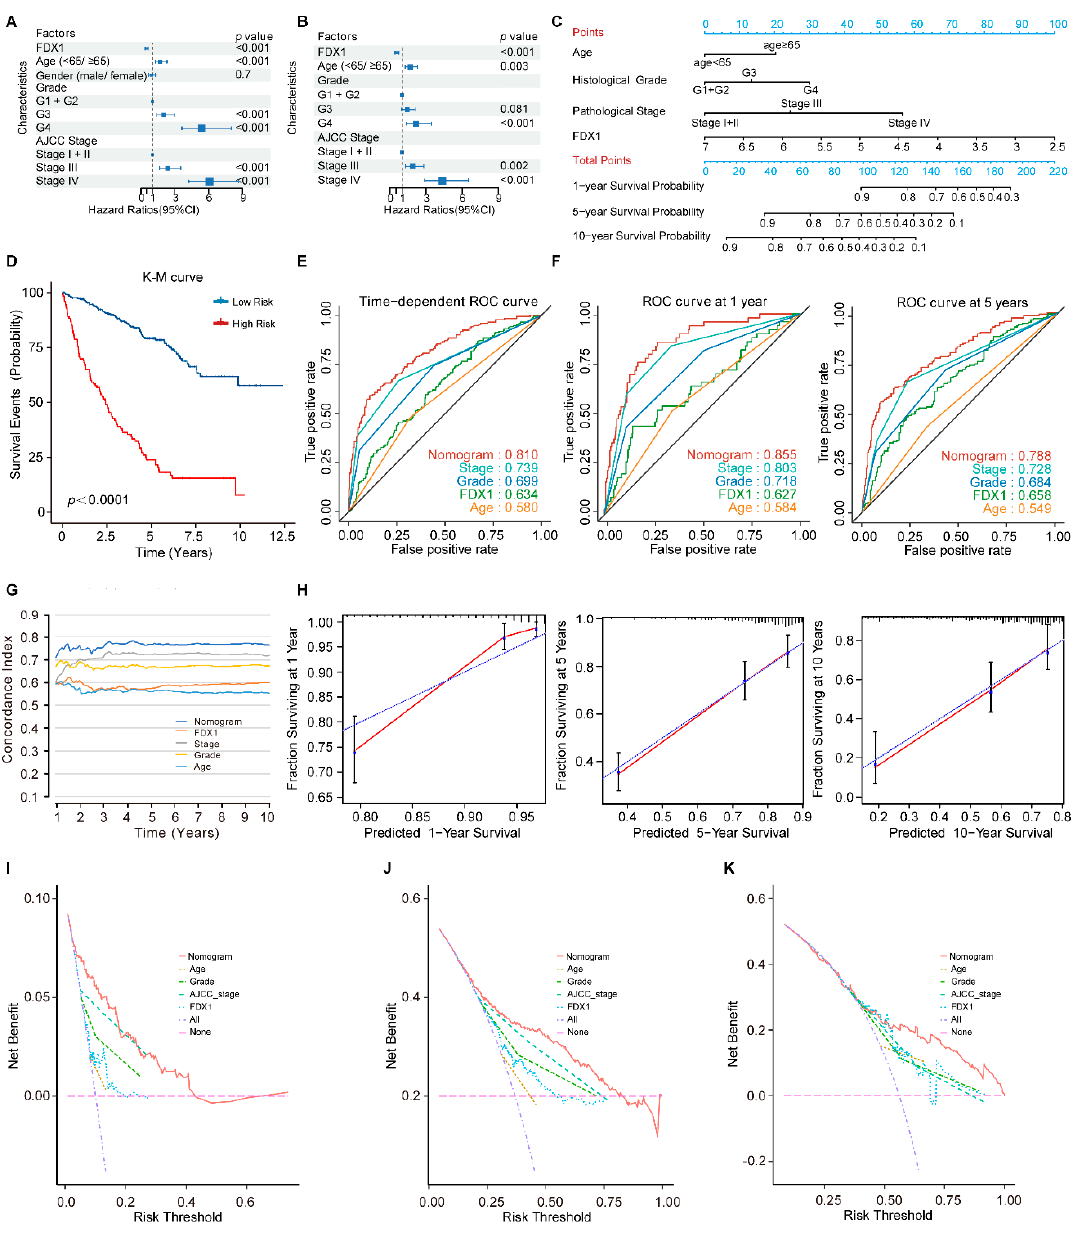
Figure 6. The FDX1 -based nomogram model in ccRCC patients. ( A ) Univariate and ( B ) multivariate regression analysis of the relation between FDX1 and clinical features regarding prognostic value; ( C ) Nomogram for predicting the probability of 1 − , 5 − , and 10 − year OS for ccRCC patients; ( D ) Kaplan–Meier curves demonstrate the prognostic performance of the nomogram; ( E , F ) Time-dependent ROC curves of the nomogram; ( G ) The prognostic performance was compared among the nomogram, FDX1 , and conventional clinical characteristics by calculating the C-index; ( H ) Calibration plots of the nomogram for predicting the probability of OS at 1, 5, and 10 years; ( I – K ) DCA plots of the nomogram, FDX1 , and clinical characteristics for predicting the probability of OS at 1, 5, and 10 years.